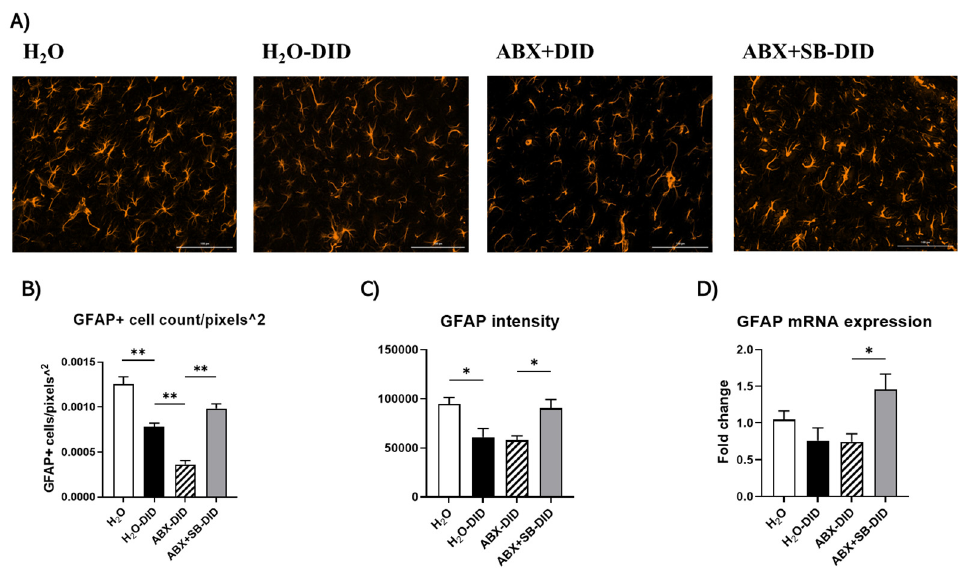
Figure 4. The effects of ABX treatment and/or SB supplementation on DID-induced changes on astrocytes. ( A ) Immunofluorescence images of hippocampal astrocytes; scale bar is 100 μ m. ( B ) Analysis of GFAP-positive cell number. The data are shown as GFAP+ cell count/pixels 2 . ( C ) Analysis of GFAP-fluorescence intensity. ( D ) mRNA levels. Data are presented as Mean ± SEM, n = 8/group; Ordinary one-way ANOVA with Tukey multiple comparisons, * p < 0.05, ** p < 0.01.